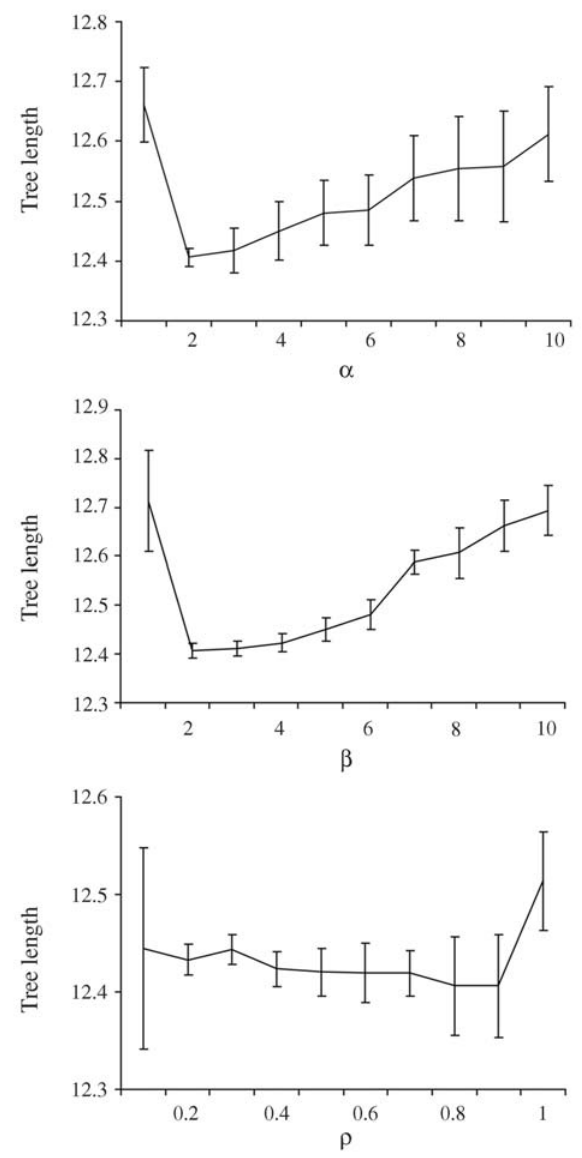
Figure 1 - Tree lengths and standard deviations produced by the ABPR al- gorithm for ϕ = 0.005, and varying α (top graphic) , β (middle) and ρ (bot-